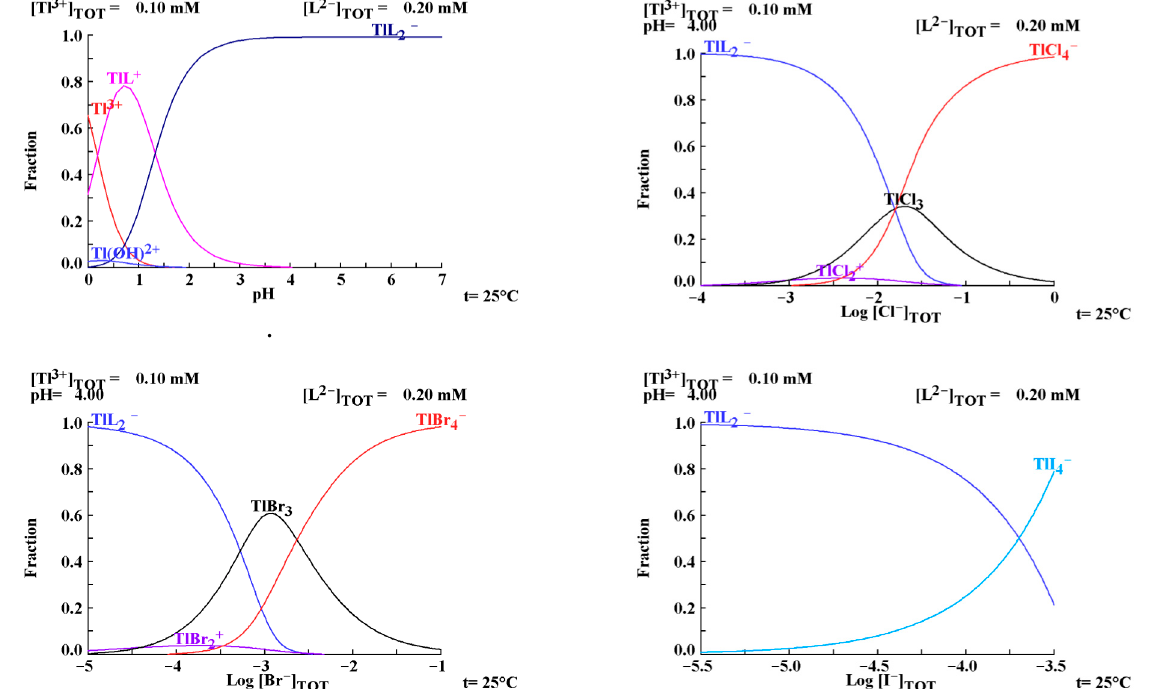
Figure A2. The distribution diagram of Tl(III)-PANS system at pH = 4.0 in the presence of chloride, bromide and iodide.